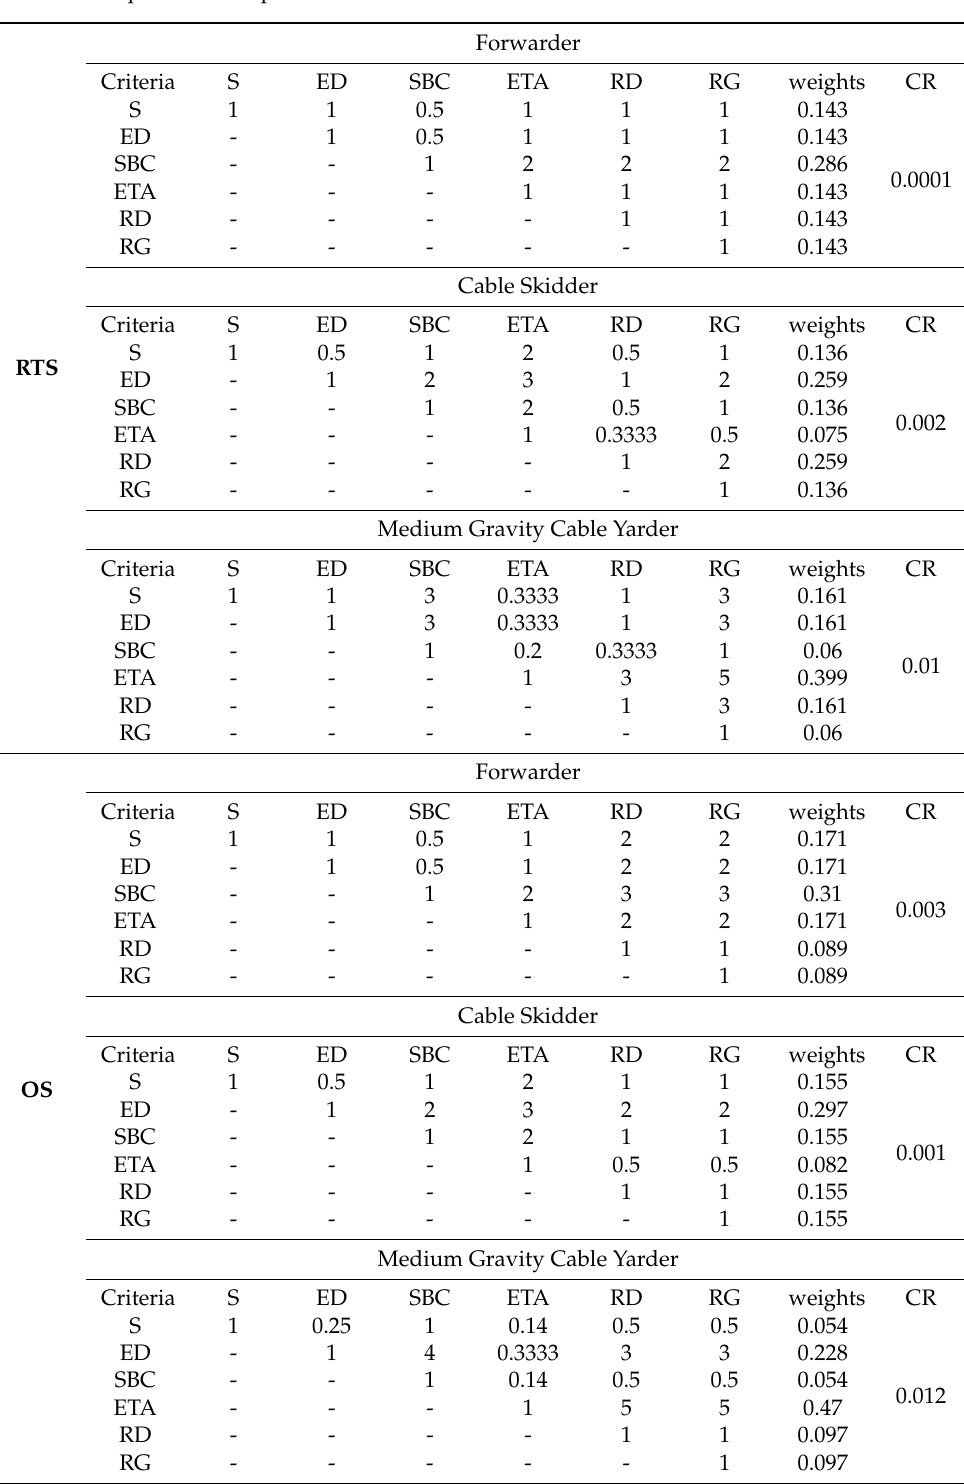
Table 4. AHP pairwise comparison